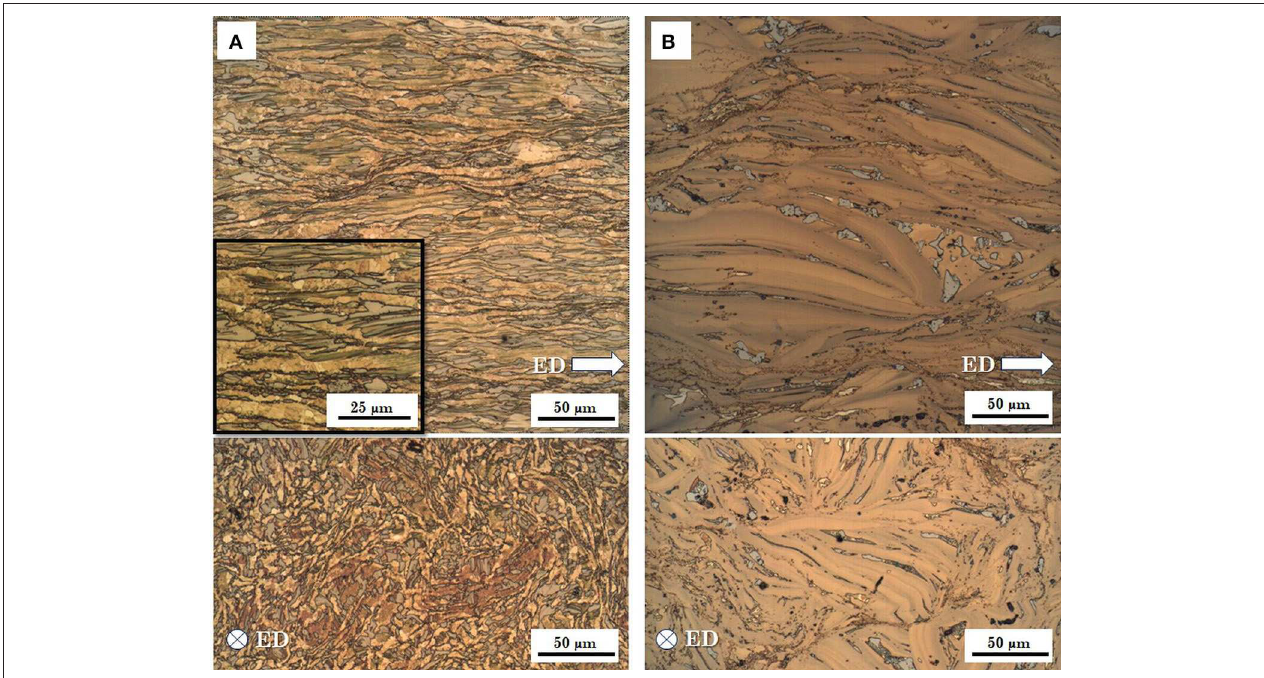
FIGURE 1 | The initial microstructure of the S32 (A) and S85 (B) alloys obtained by confocal light microscope along and perpendicular to